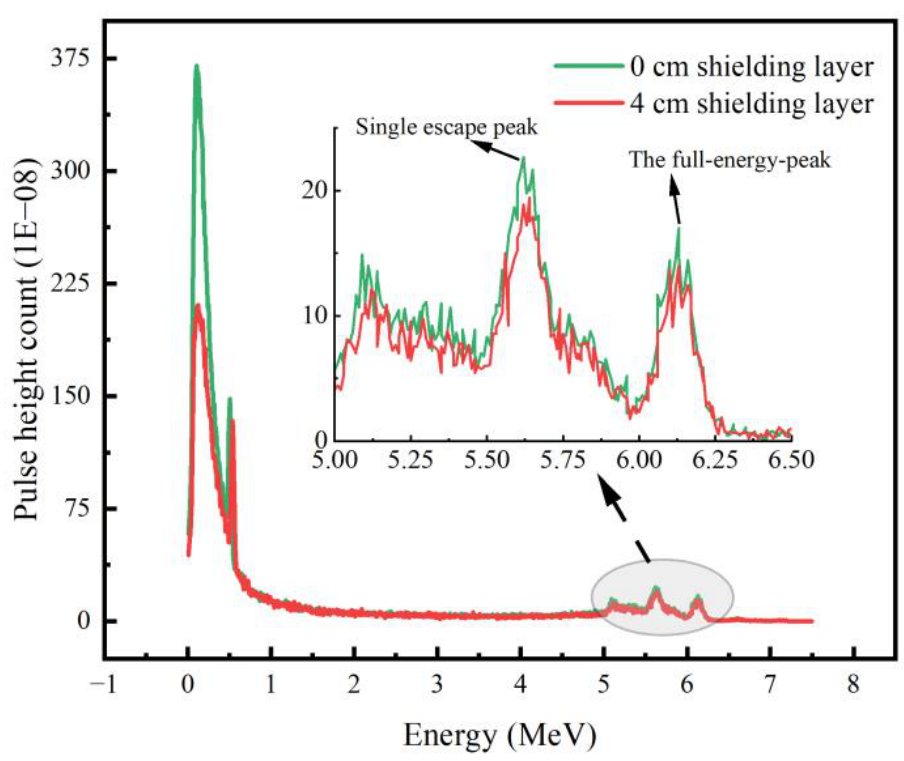
Figure 3. Energy spectrum measurement of the 16 N radiation monitoring system without the shield- ing layer and with a 4 cm tungsten shielding layer.